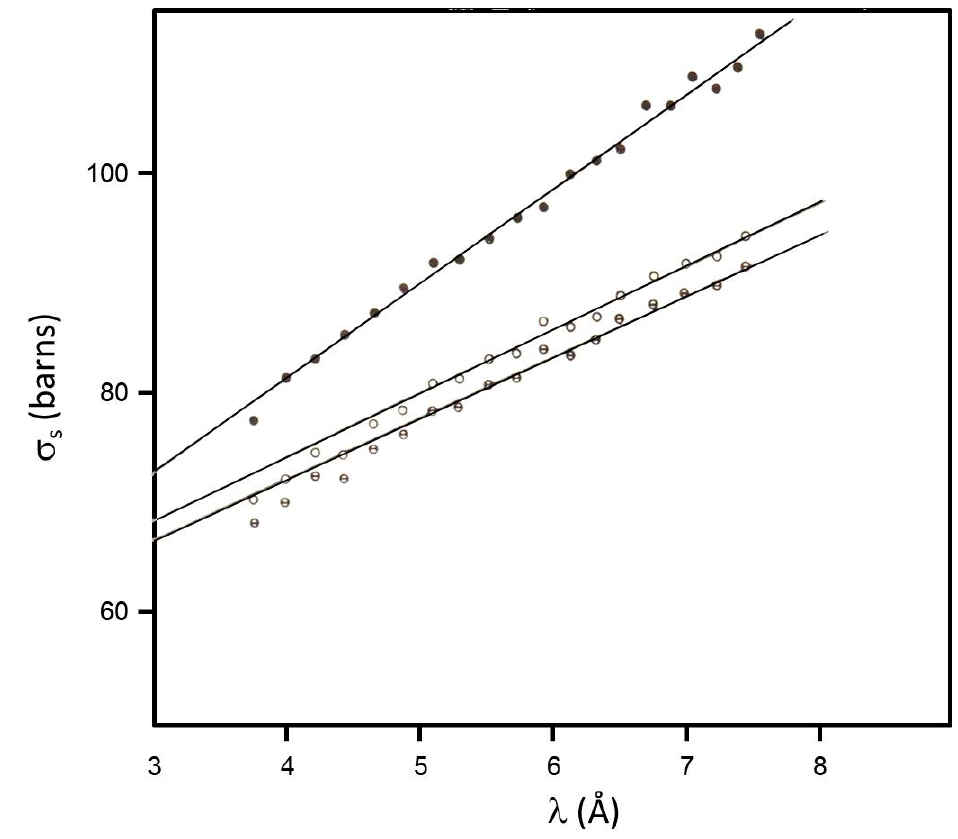
Figure 2. Total scattering cross-section per H atom, σ s /H, for tert-butanol, as a function of the neutron wavelength λ . Results for the liquid (upper) and for the two limiting values of the solid state. Straight line adjustment is well defined over the whole λ interval in the liquid state, and for λ > 5 Å in the solid